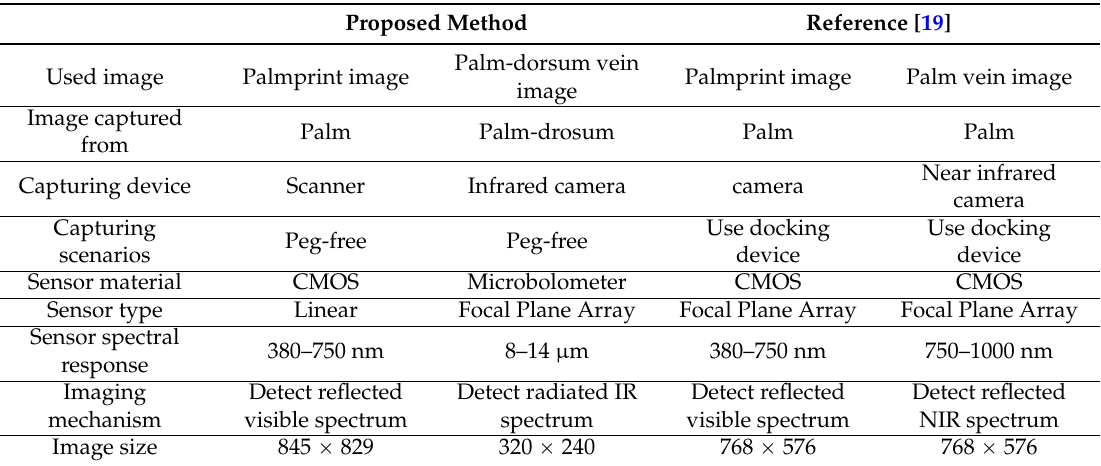
reference [19] and the proposed